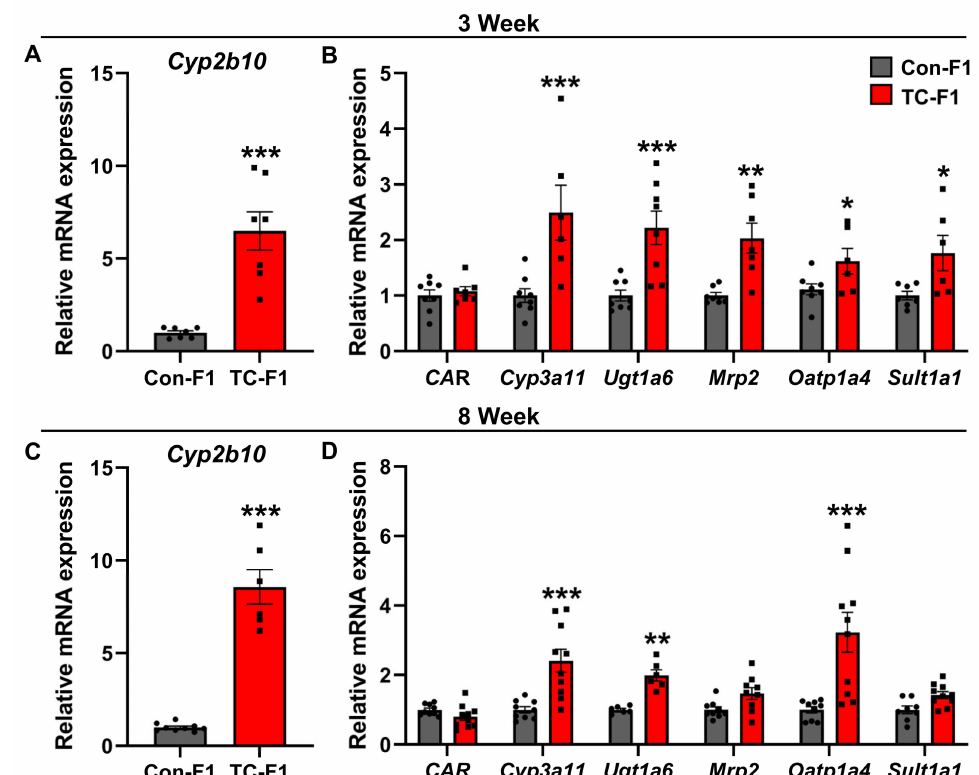
Figure 2. Maternal TC exposure results in abnormal expression of hepatic nuclear receptor and drug- metabolizing enzymes in F1 female mice. ( A ) mRNA expression of hepatic Cyp2b10 in 3-week-old F1 female mice. ( B ) mRNA expression of hepatic CAR , Cyp3a11 , Ugt1a6 , Mrp2 , Oatp1a4 and Sult1a1 in 3-week-old F1 female mice. ( C ) mRNA expression of hepatic Cyp2b10 in 8-week-old F1 female mice. ( D ) mRNA expression of hepatic CAR , Cyp3a11 , Ugt1a6 , Mrp2 , Oatp1a4 and Sult1a1 in 8-week-old F1 female mice. n = 6–10. Data are presented as mean ± SEM. * p < 0.05; ** p < 0.01; *** p < 0.001 vs.